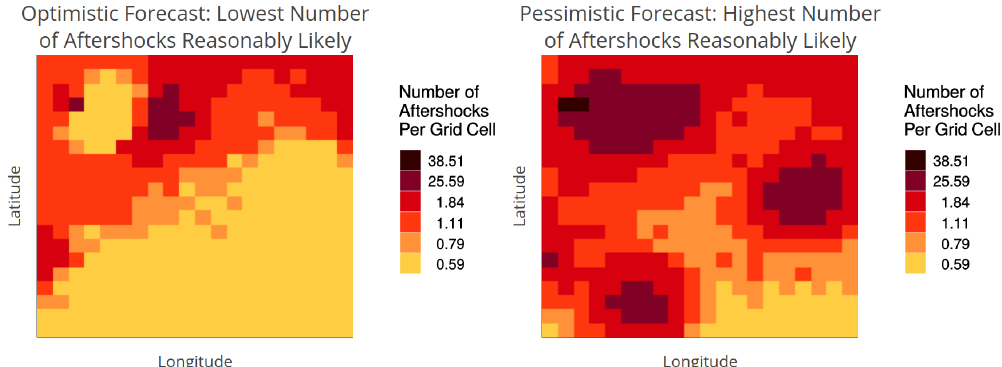
Figure 4. Bounds uncertainty visualization: lower- and upper-bound maps of a 95% confidence interval around the most likely forecasted aftershock rate. The forecast uncertainty at each location can be inferred through its difference in colors between the maps. Locations with high uncertainty have a difference of four to five colors, regardless of their most likely forecasted rate (e.g., lower-left and middle-right zones). We designed another scenario for when both the most likely forecasted rate and forecast uncertainty are high: the lower and upper bounds showed red and brown, respectively (e.g., several grid cells in the upper left zone). This scenario represents a case where the forecast’s lower bound is very high but, due to high uncertainty, the upper bound is extremely